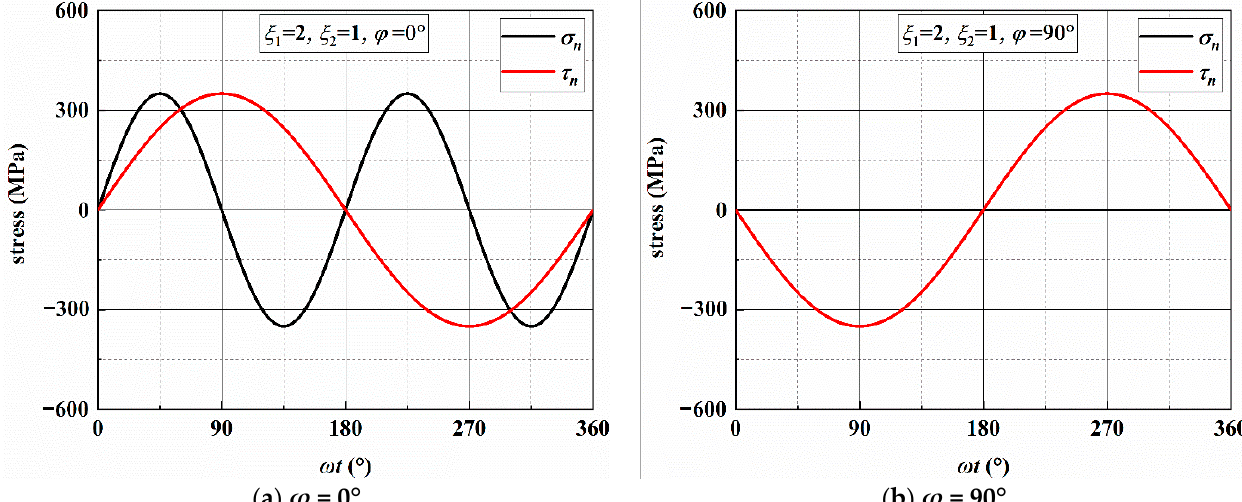
Figure 6. Variation in stresses on the MSSA plane under AS-1.